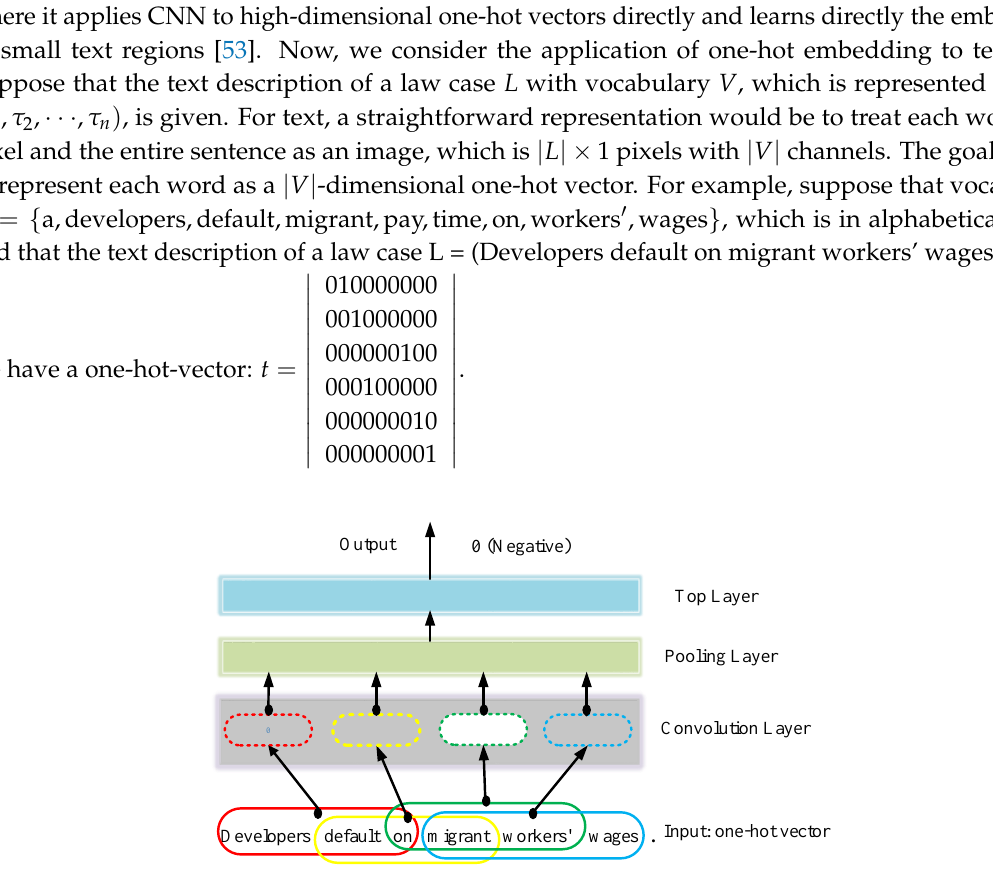
Figure 4. One-hot CNN example. Region size three, stride